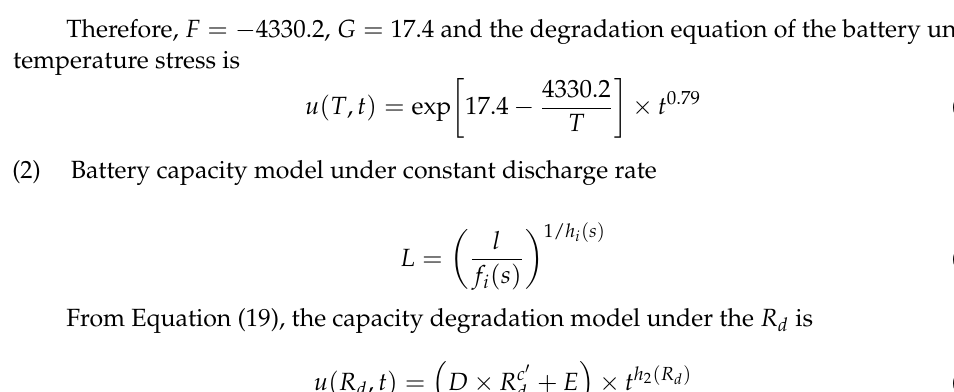
Figure 6. Recession parameter curves at different discharge rates.